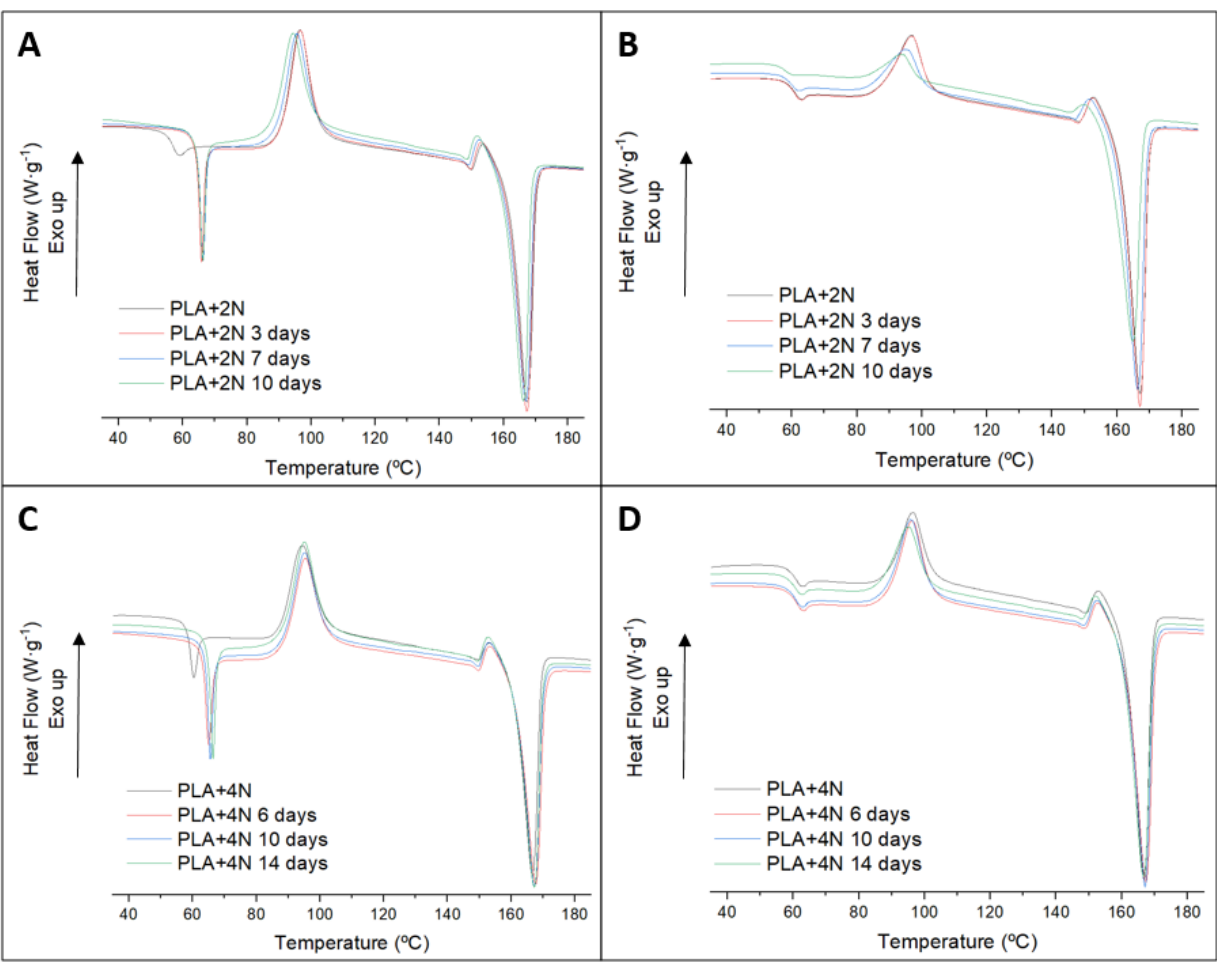
Figure 7. FT-IR of PLA reinforced with 2 ( left ) and 4% w / w ( right ) and its degraded samples after 10 and 14 days, respectively.